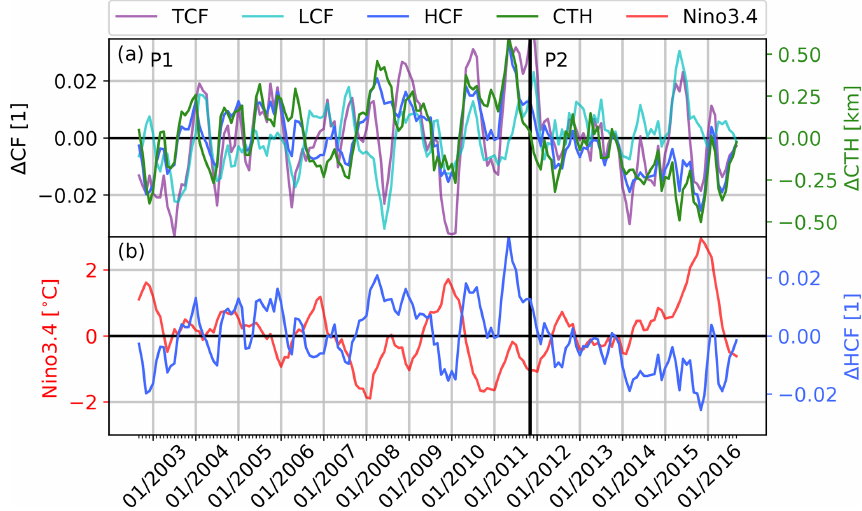
Figure 3. (a) Time series of the tropical Atlantic 3-month running mean anomalies of CTH, TCF, HCF, and LCF. Panel (b) is as (a) but comparing the HCF and the Nino3.4 index (NOAA climate prediction center). The Pearson correlation coefficient is found to be − 0 .